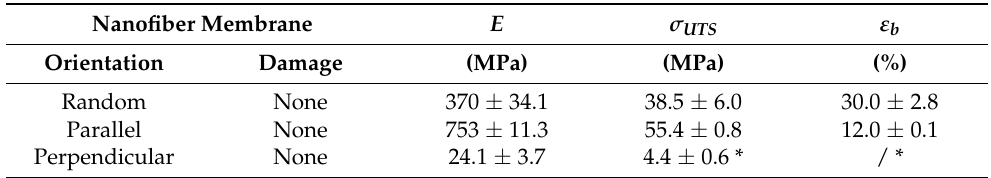
Table 1. Overview of the mechanical data of all tested membranes. The strength is determined based on the nominal cross-section of the specimens.